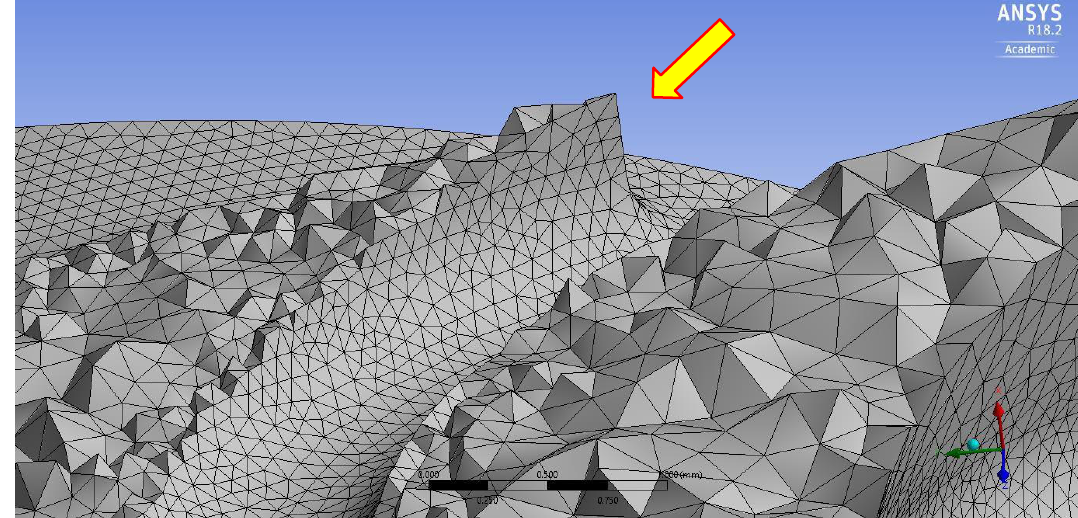
Figure 45. Blade root trailing edge mesh detail (section).